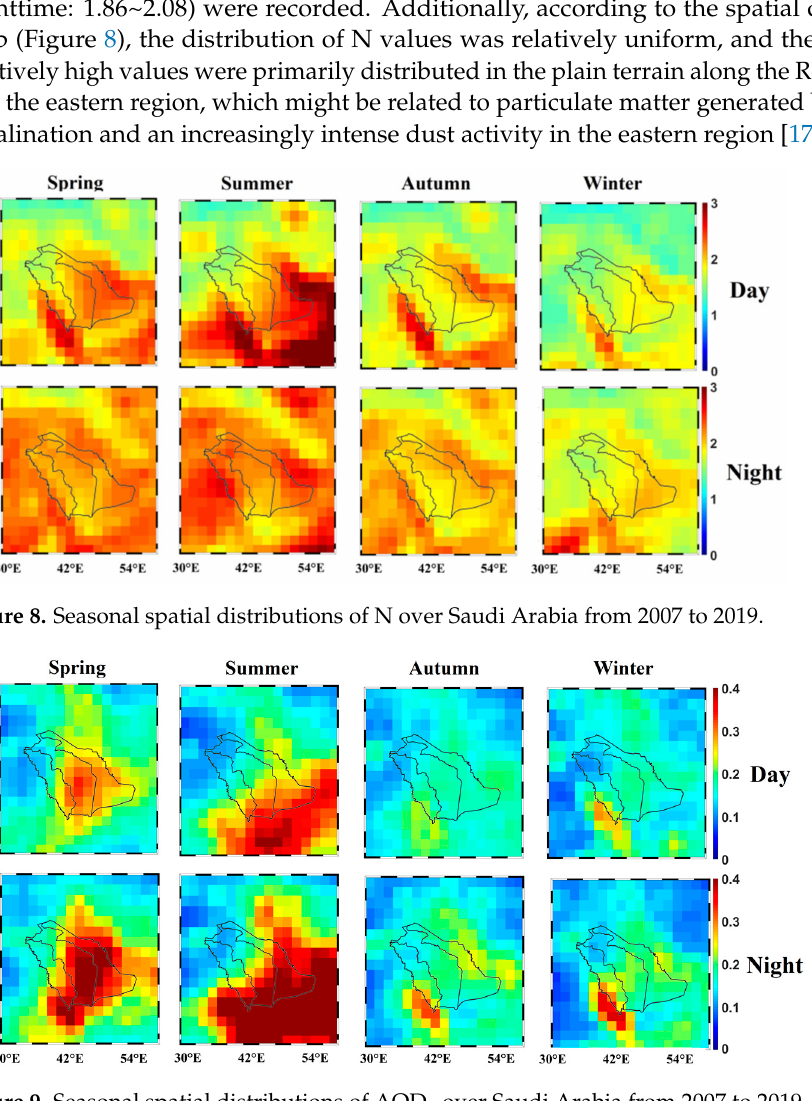
Figure 9. Seasonal spatial distributions of AOD 1 over Saudi Arabia from 2007 to 2019.